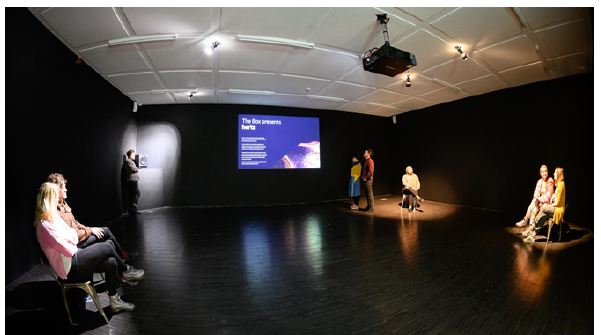
Figure 10. Finalised version of the hertz infrasound installation at The Box at We The Curious, Bristol. Members of the public sit on furniture which has transducers beneath. The subwoofer is located in the far-left corner. Information about hertz is projected onto the